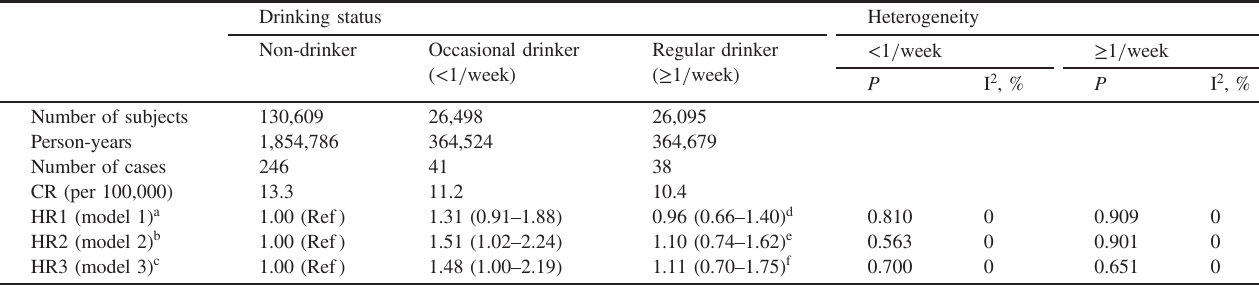
Table 2. HRs and 95% CIs of bladder cancer risk according to drinking status in women Drinking status Non-drinker Number of